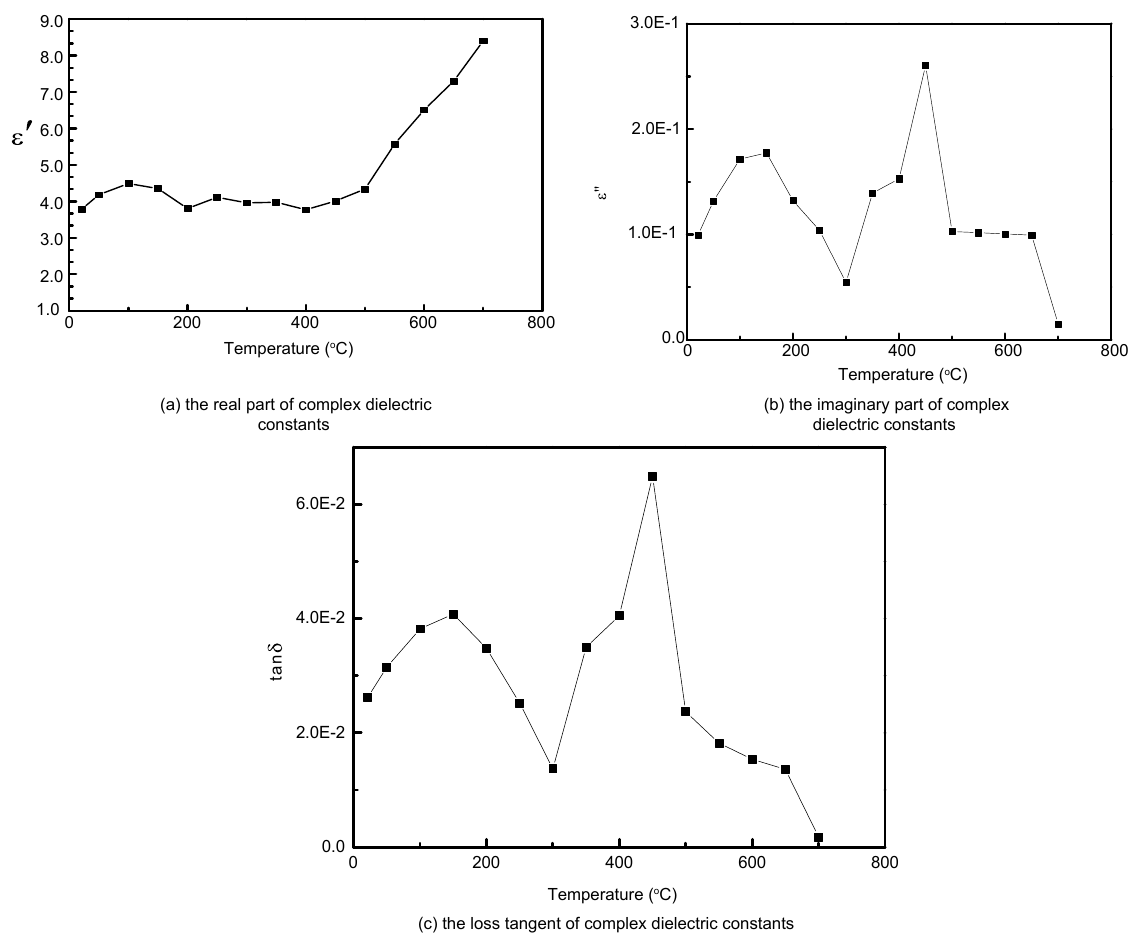
Figure 7: The relationship between dielectric constants and